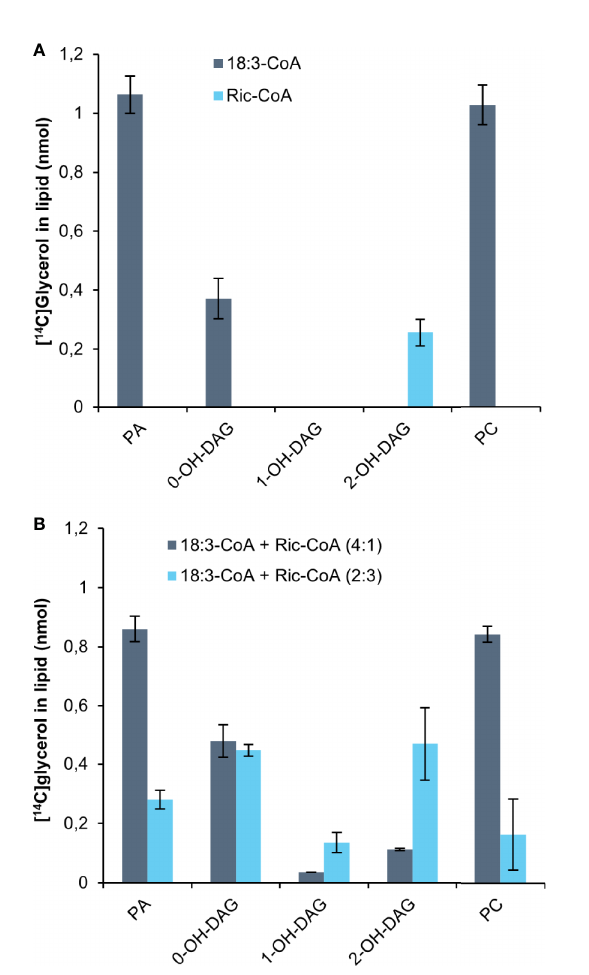
FIGURE 6 | Time-course incorporation of radioactivity into chloroform soluble lipids in microsomal fractions of yeast expressing C. sativa PDCT fed [ 14 C] glycerol labeled glycerol 3-phosphate and different acyl-CoAs. (A) 18:1-CoA, (B) 18:2-CoA, and (C) 18:3-CoA. PA, phosphatidic acid; PC, phosphatidyl- choline; DAG, diacylglycerol. Average value shown ± SD, n = 3 replicates.